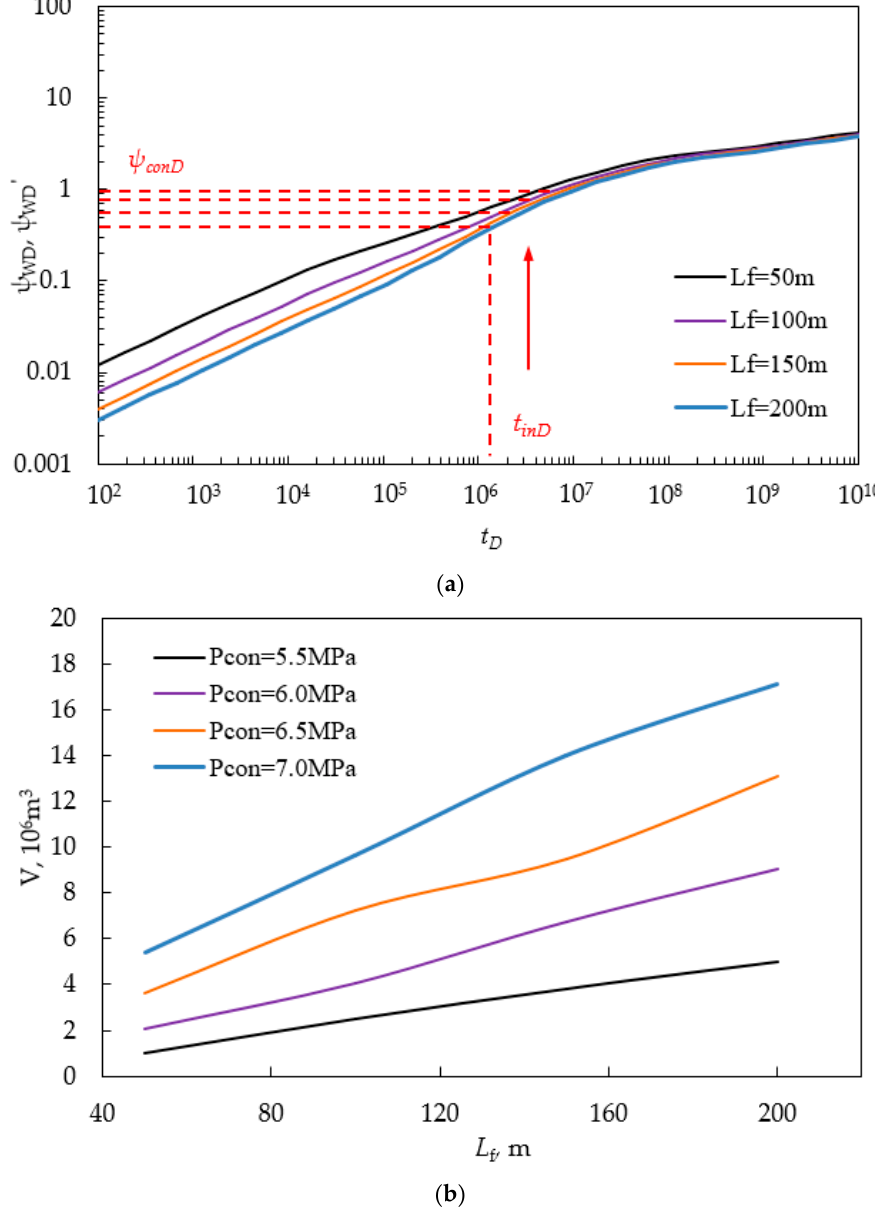
Figure 15. ( a ) Comparison pressure with different fracture half-length; ( b ) comparison of CO 2 storage capacity with different fracture half-length.